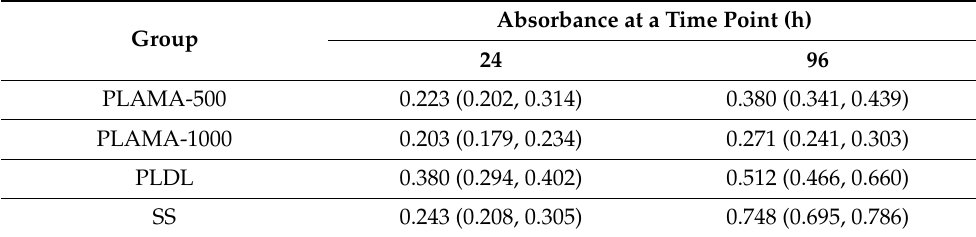
Table 11. Numerical results of the cell viability test.